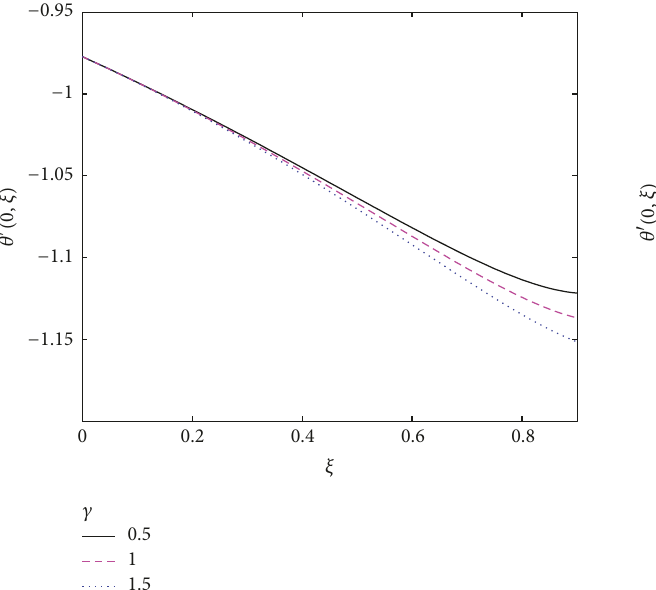
Figure 22: Effect of Pr on 𝜃 󸀠 (0,𝜉) ( 𝜎 = 𝛾 = 0.5, 𝜆 = 1, Sc = 2, ℏ = −0.5 ).